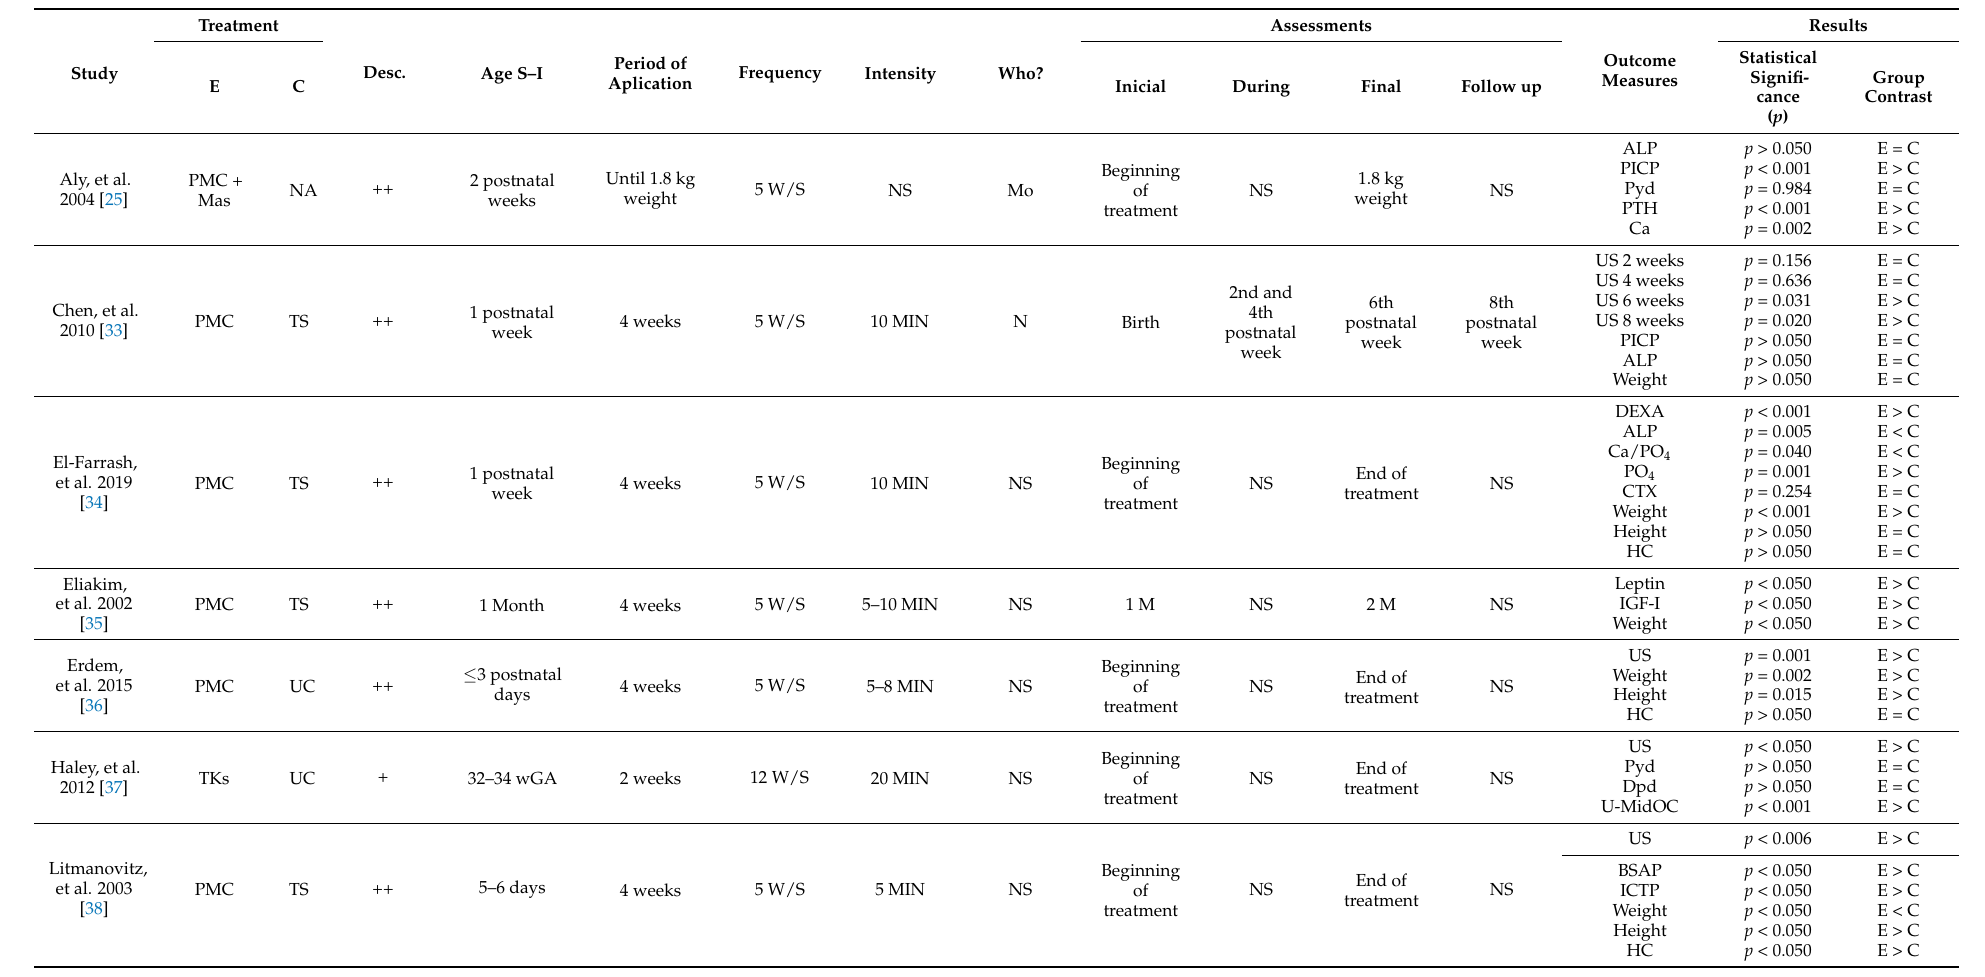
Table 2. Characteristics of the physical therapy treatments and their